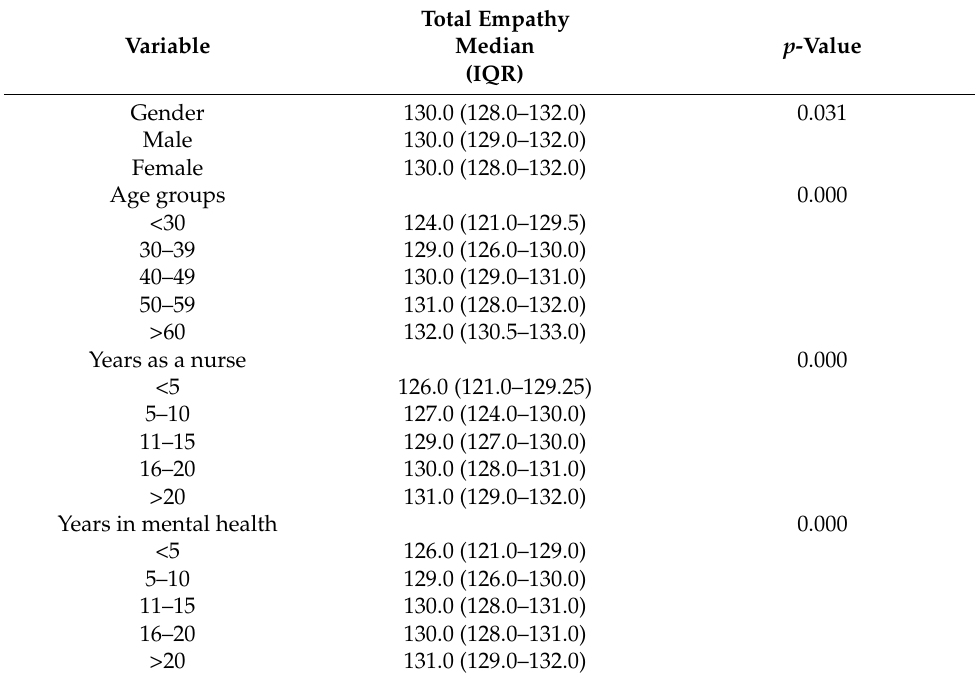
Table 2. Association between empathy and sociodemographic